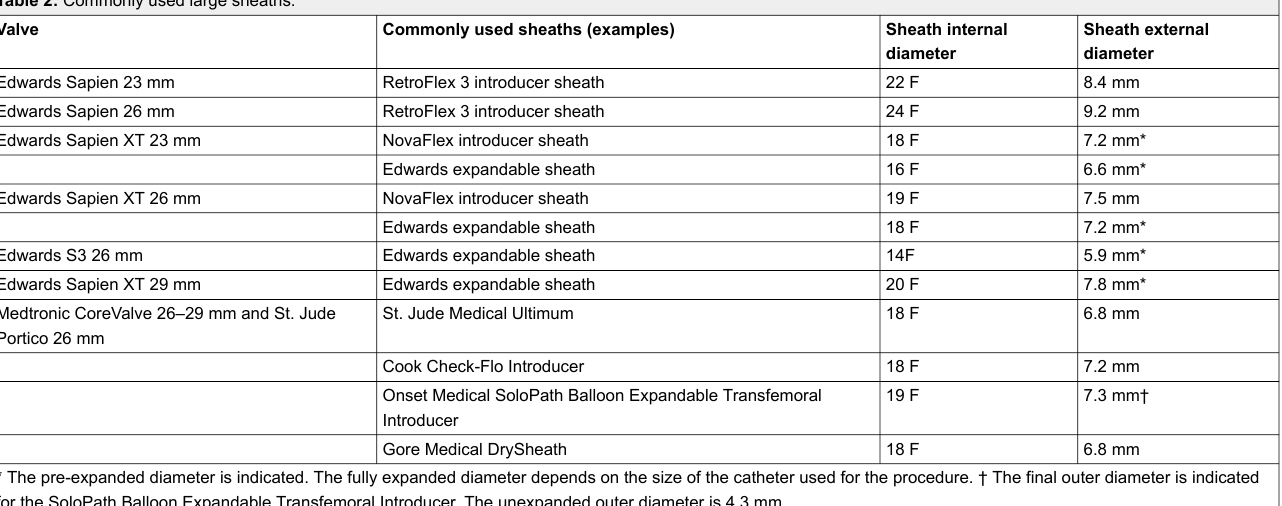
Table 2: Commonly used large sheaths.